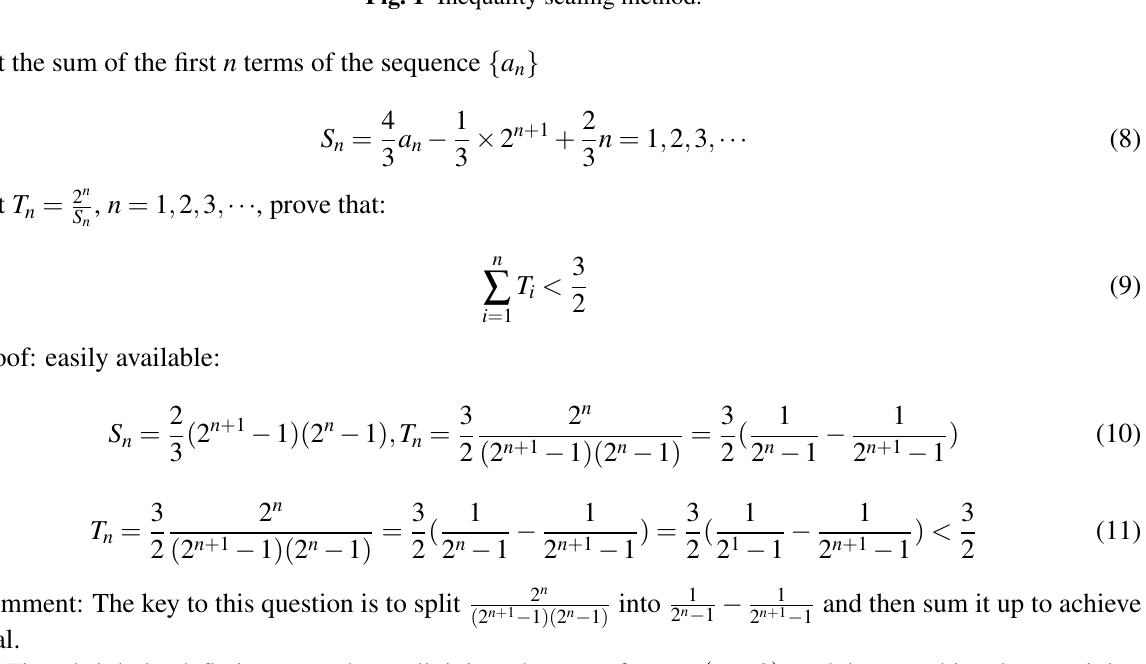
Fig. 1 Inequality scaling